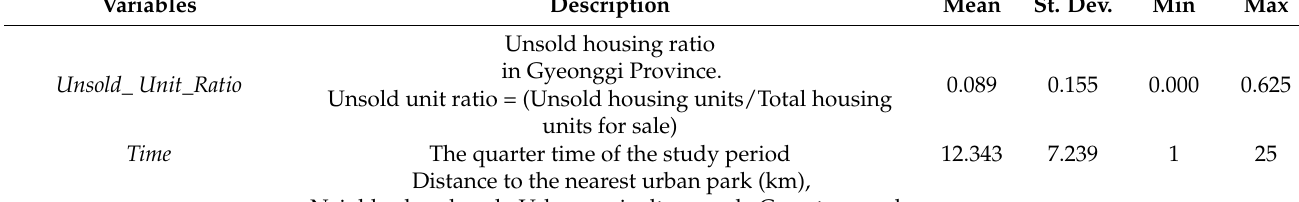
Table A1. A detailed explanation, with descriptive statistics, of variables included in the analytical model.